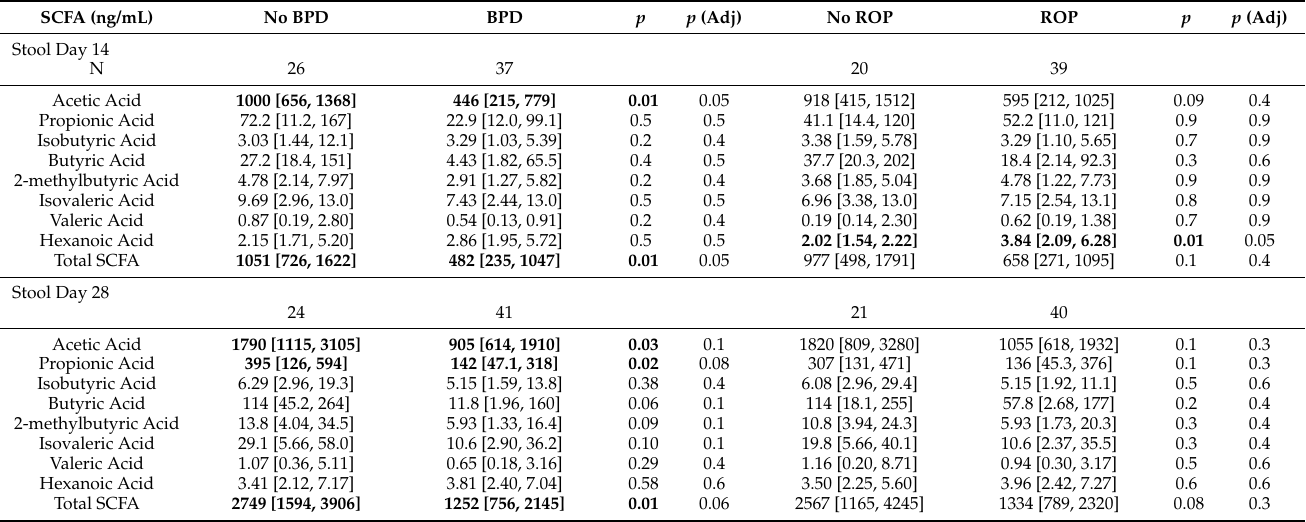
Table 4. Short-chain fatty acid levels in neonatal stool samples on day 14 and day 28 after delivery based on neonatal comorbidities 1 .